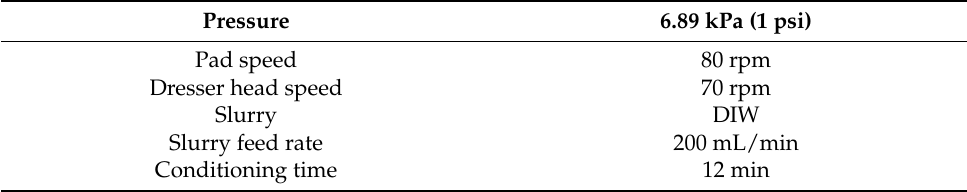
Figure 5. Kinik 3EA-3 diamond dresser. Table 1. Characteristics of IC1000 pad. Table 2. Break-in parameters of pad dressing.